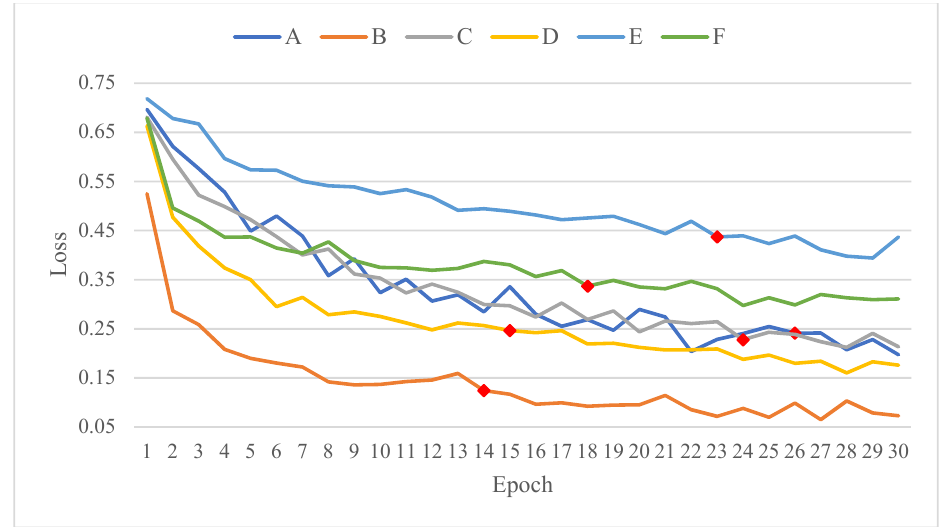
Figure 8. MCNN6 loss of six types of RC damage. Table 4. Evaluation results of MCNN6 on six types of damage.